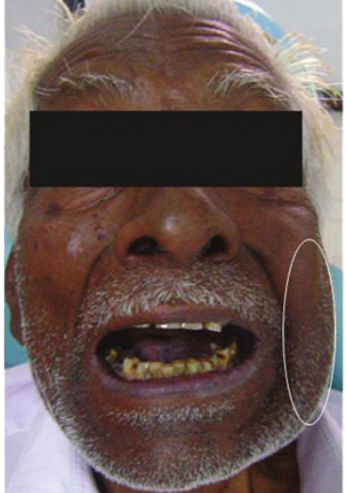
Figure 1: Swelling on left side of the face with associated trismus.